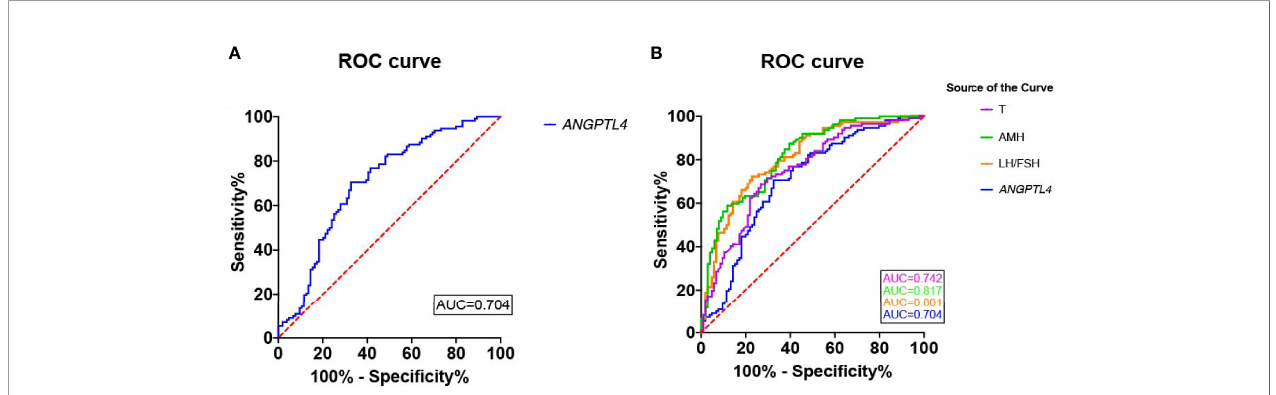
FIGURE 4 | Reciever operating characteristics (ROC) analysis of ANGPTL4 and clinical characteristics for discriminating PCOS. (A) Reciever operating characteristics (ROC) analysis of ANGPTL4 for discriminating PCOS. The AUC of ANGPTL4 was 0.704(95% CI 0.633-0.774, P<0.001). (B) Reciever operating characteristics (ROC) analysis of 4 clinical characteristics for discriminating PCOS.